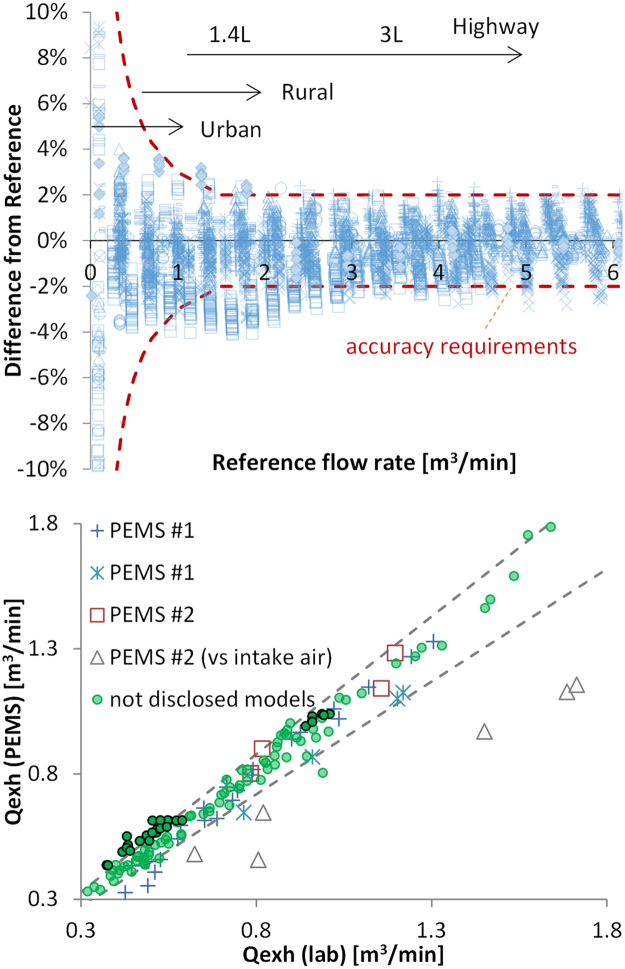
Upper panel: Checks of 44 light-duty EFMs against a traceable standard at the instrument manufacturer's site after 1 year of use (data from one instrument manufacturer). Arrows show typical exhaust flow rate ranges for various light-duty vehicles. Lower panel: Comparison of EFMs with other EFMs or CVS estimated flows. Dotted lines show ± 10% differences. Circles with black frame are from one stakeholder.